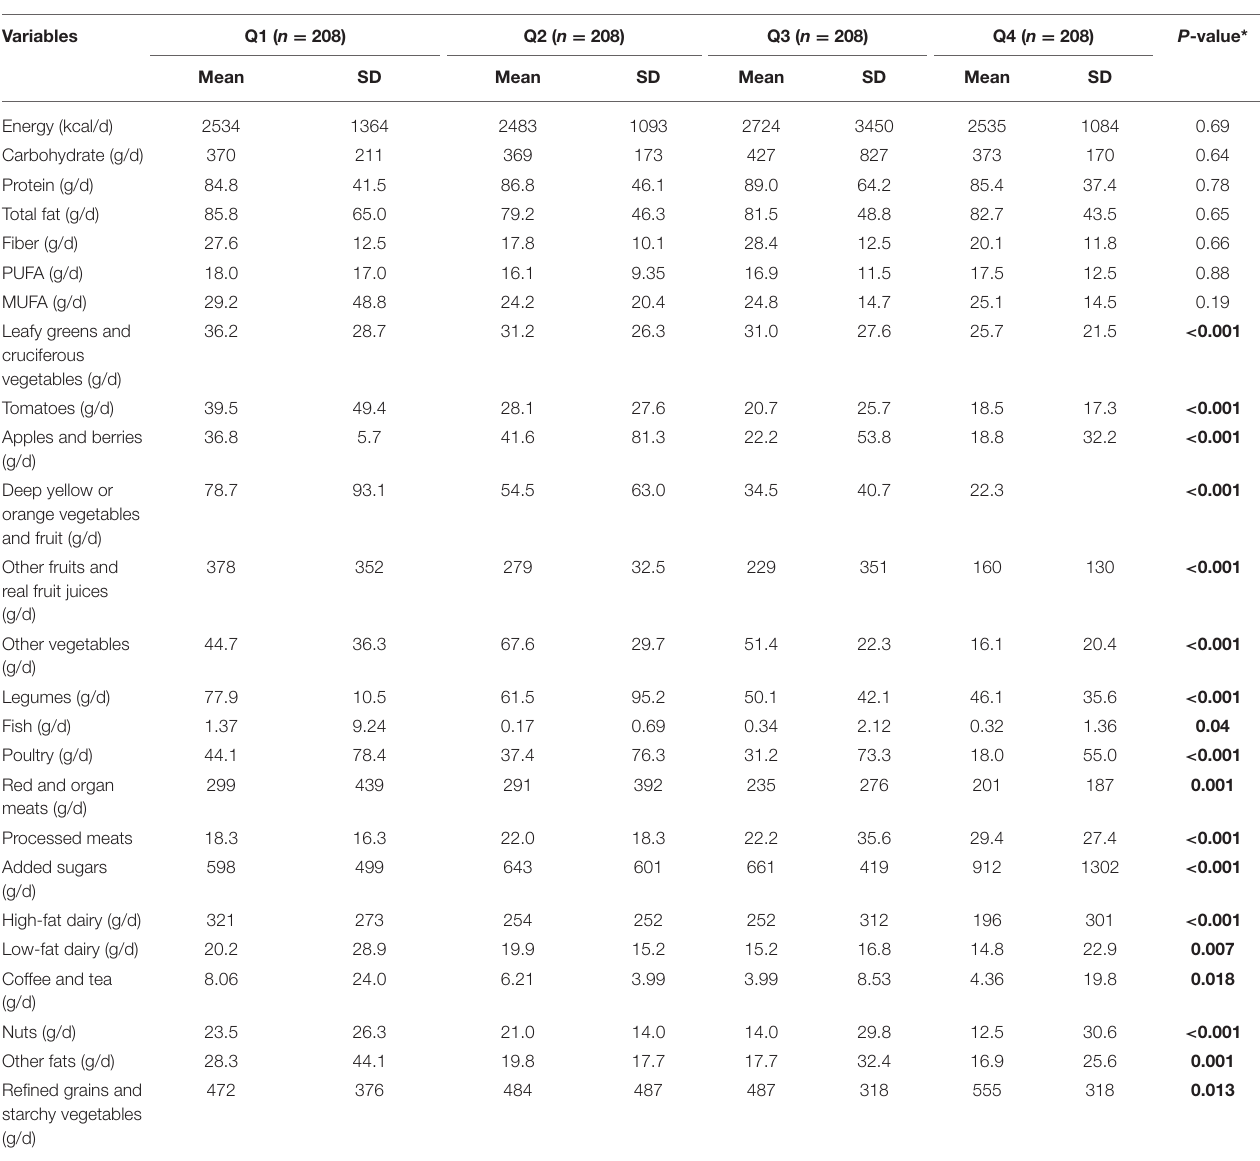
TABLE 3 | Dietary intakes of the study participants across quartile of the DLIS in Tehranian adults.